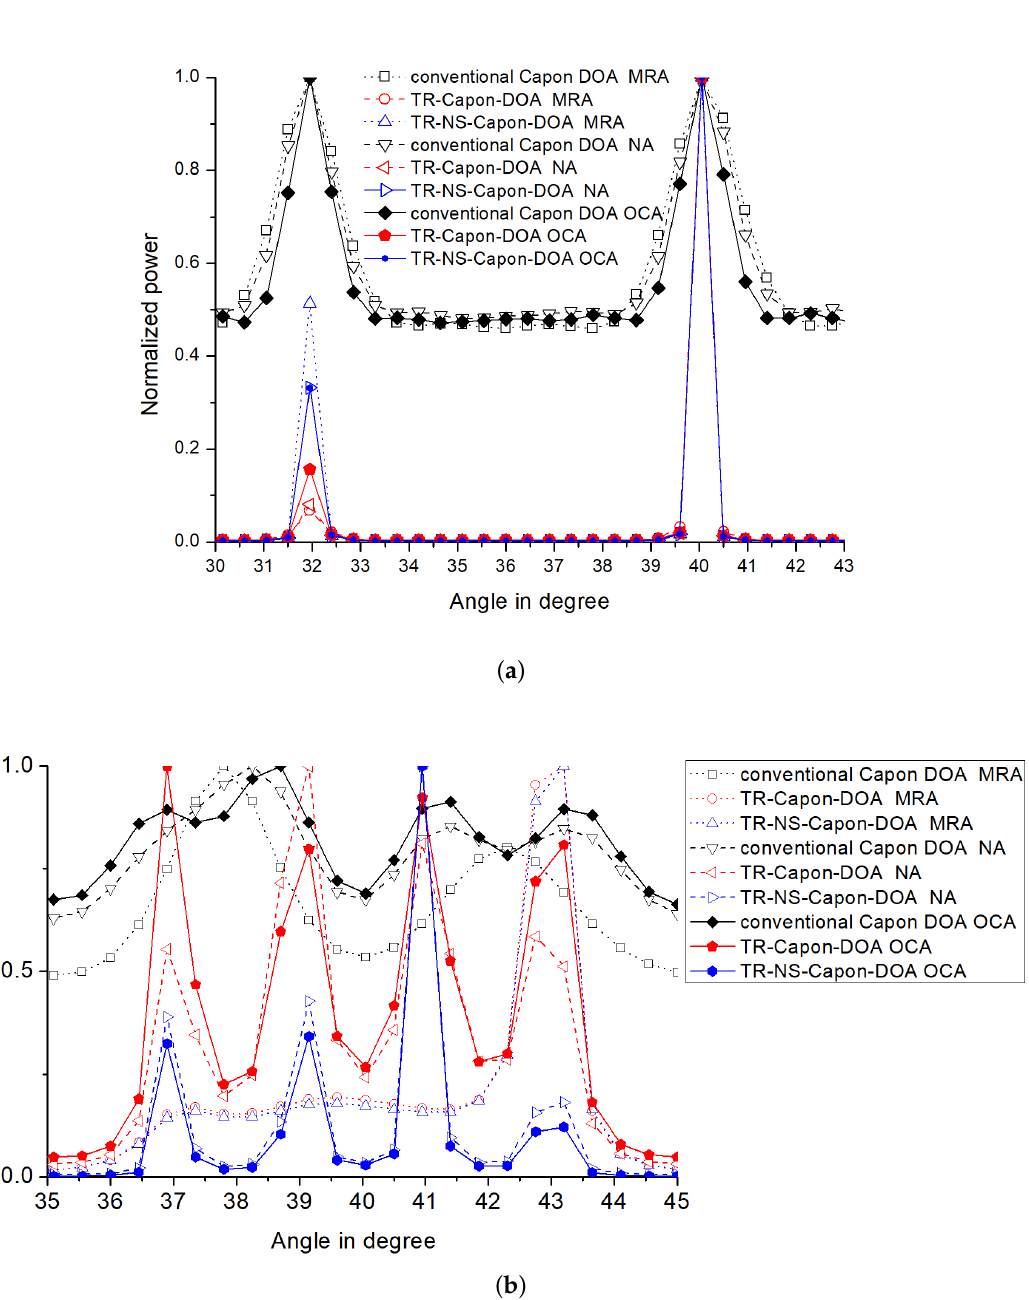
Figure 14. Normalized power spectra versus angles for conventional Capon DOA, TR-Capon-DOA and TR-NS-Capon-DOA algorithms with the configurations of MRA, NA and OCA under the condition of LFM used as ES, SNR = − 15 dB and ( a ) 2-path ( b )